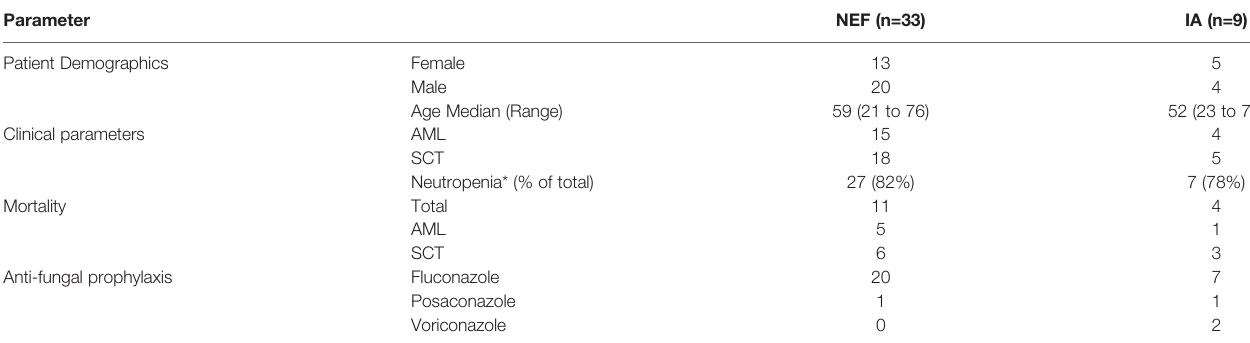
TABLE 1 | Patient information including primary demographics, clinical parameters, mortality, and anti-fungal prophylaxis for no evidence of fungal disease (NEF) and invasive aspergillosis (IA) patients.